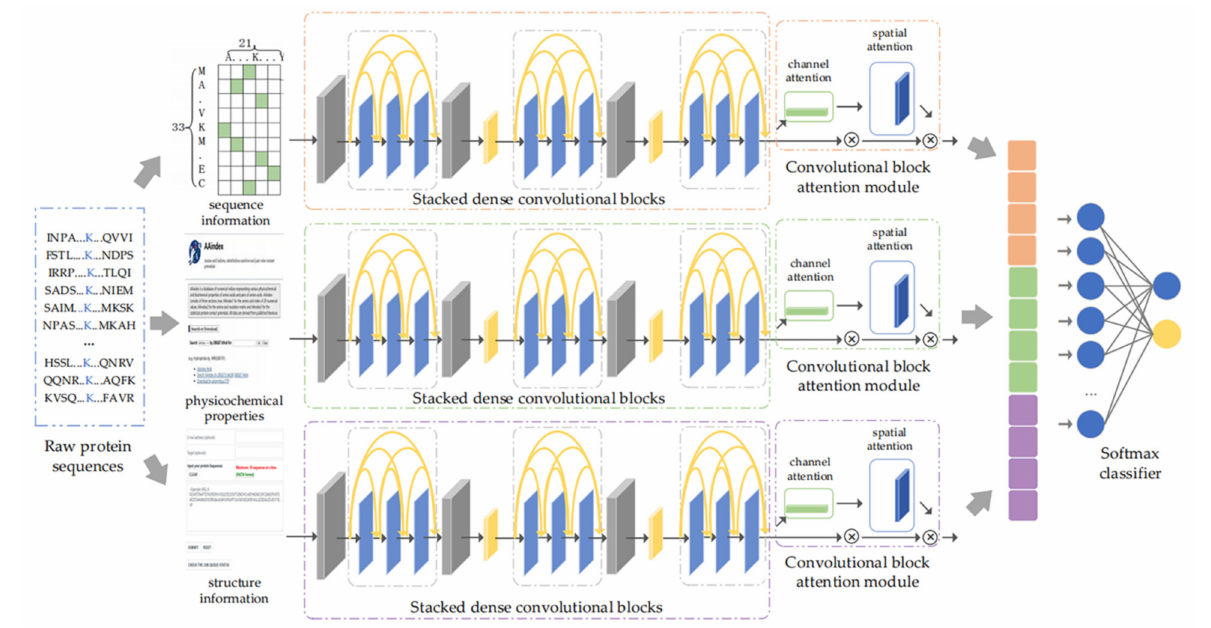
Figure 1. The proposed